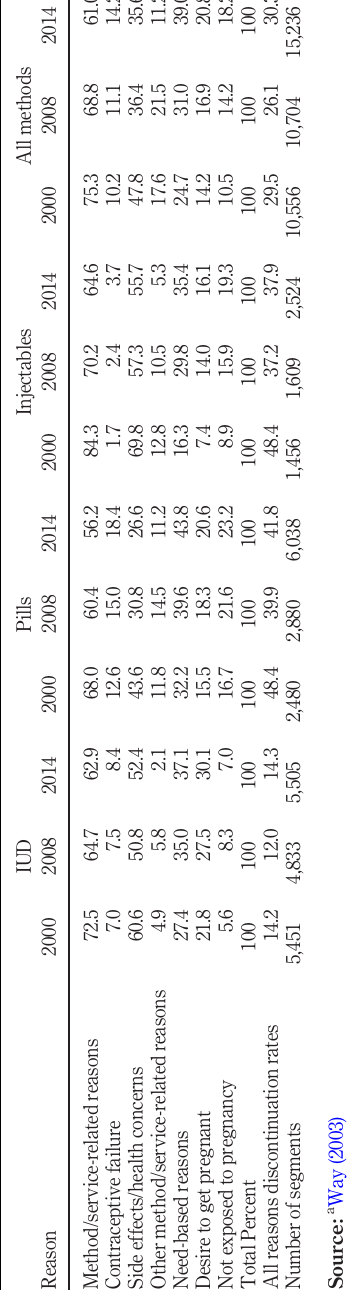
Table II. Percent